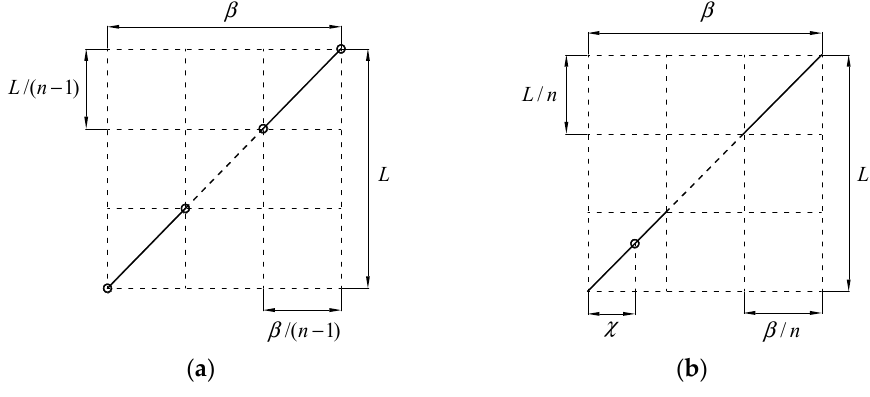
Figure 4. Segmentation modes: ( a ) mode 1; ( b ) mode 2.